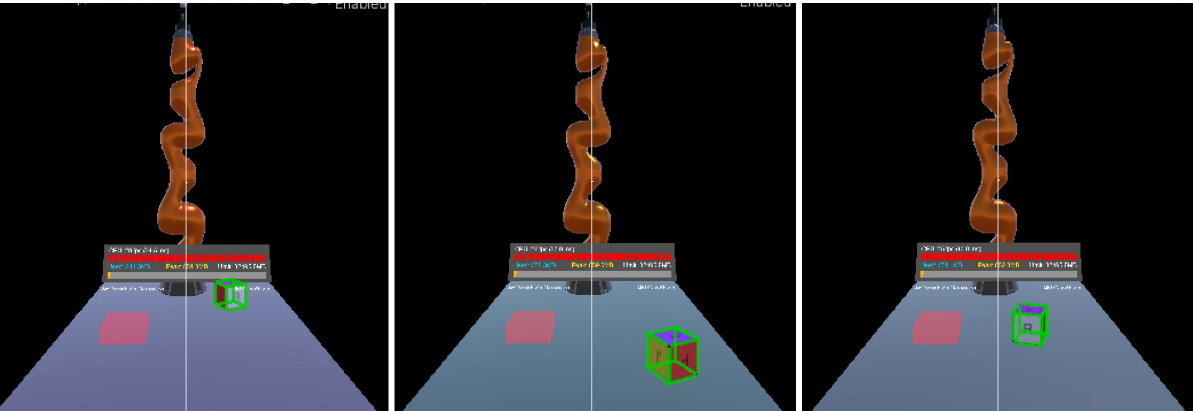
Figure 10. Examples of the stored RGB images that were captured during the simulation. Next, the dataset that was gathered from the virtual environment was used to train the DCNN model to find the target position and rotation. The applied model was adapted and modified from [46]. Its architecture is shown in Figure 11, which was based on the convolutional neural network (CNN) VGG-16 architecture. The input models were the previously collected RGB images with a fixed size of 224 × 224. The fully connected layers were downsized to 256 × 64. The network was composed of five sets of convolutional layers. The outputs from the head of the network were (1) (x,y,z) for position and (2) (qx,qy,qz,qw) for